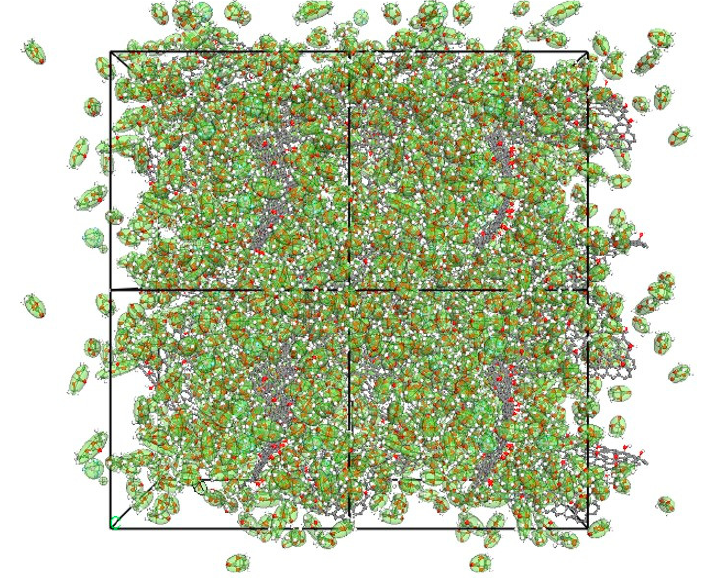
Figure 3. Snapshot of the HGNS / electrolyte system for the final-size box in thermal equilibrium.